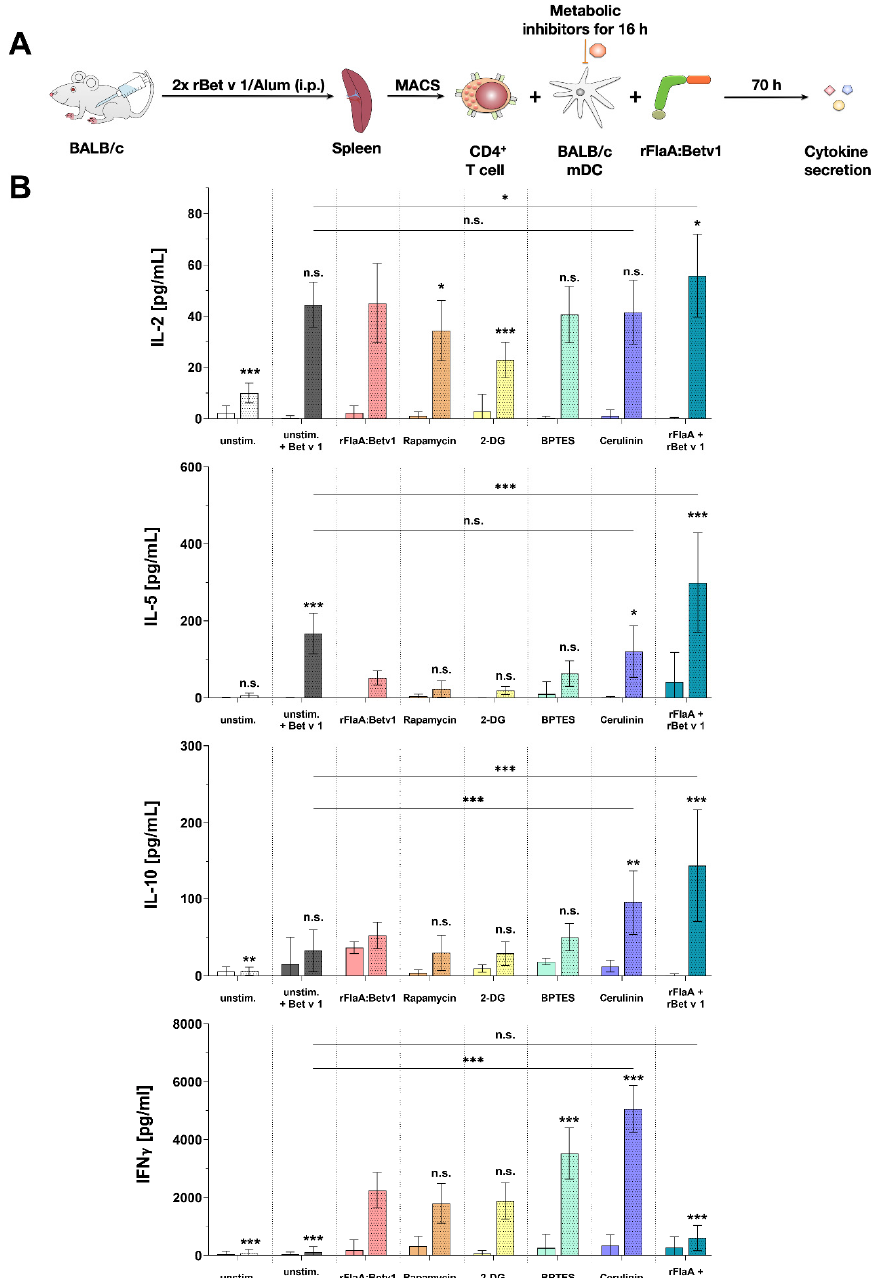
Figure 6. Fatty acid metabolism contributes to the T cell modulating properties of rFlaA:Betv1- stimulated mDCs. BALB/c mDCs were co-cultured with CD4 + T cells isolated from spleens of BALB/c mice that were previously immunized with the major birch pollen allergen Bet v 1 and alum. Prior to co-cultures, mDCs were pretreated for 16 h with metabolic inhibitors (5 nM rapamycin, 0.5 mM 2-DG, 1 µ M BPTES, or 0.2 µ g/mL cerulenin), then the medium was changed. mDCs were either left alone (solid bars) or T cells were added (bars with dotted pattern). Cultures were either left unstimulated or re-stimulated with either 2 µ g/mL Bet v 1 with and without the addition of equimolar amounts of either rFlaA:Betv1 or rFlaA+Betv1 for additional 70 h ( A ). Cytokine secretion was determined for IL-2, IL-10, IL-5, and IFN- γ ( B ). Data are mean results of four independent experiments ± SD. Statistical comparisons were performed by 2-way ANOVA with correction for multiple comparisons according to Dunnett and indicated as: n.s. p -value > 0.05, * p -value < 0.05, ** p -value < 0.01, or *** p -value <